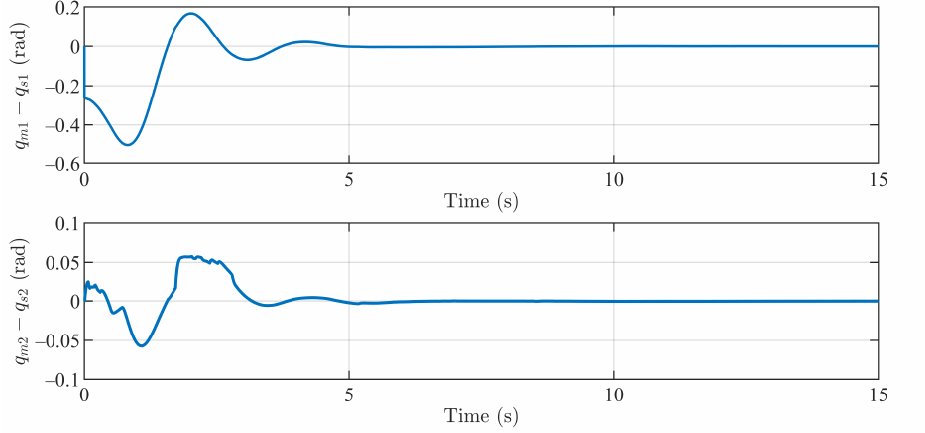
Figure 6. Joint tracking errors of the master and slave